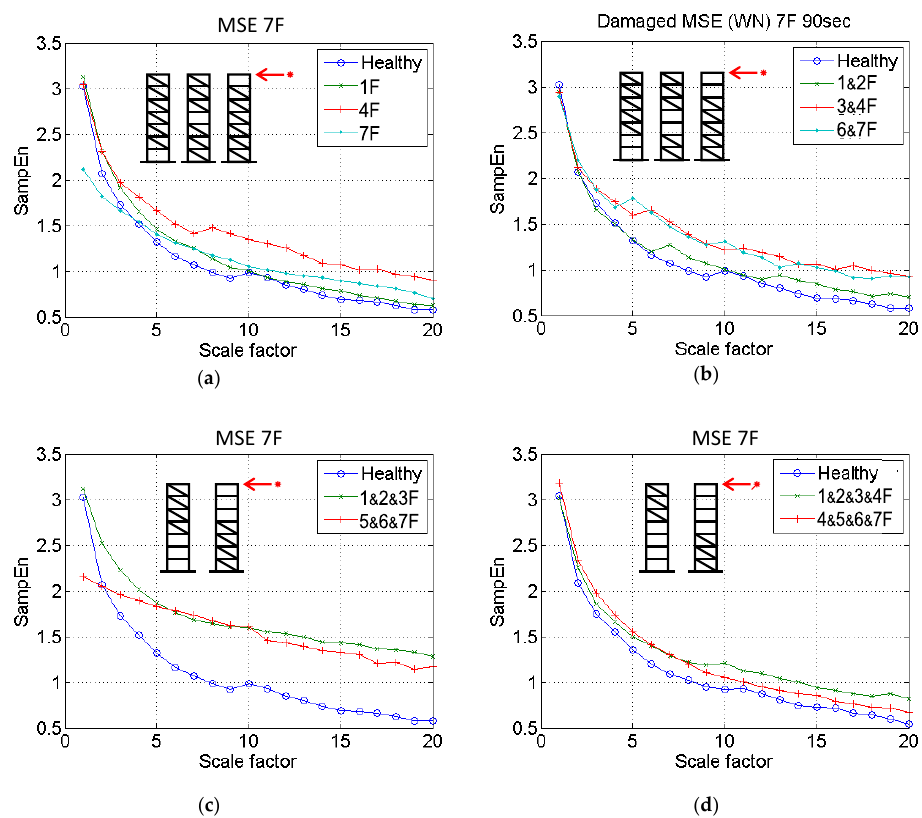
Figure 4. Multiscale sample entropy (MSE) diagrams of different damage categories. ( a ) one-story damage; ( b ) two-story damage; ( c ) three-story damage; ( d ) four-story damage.